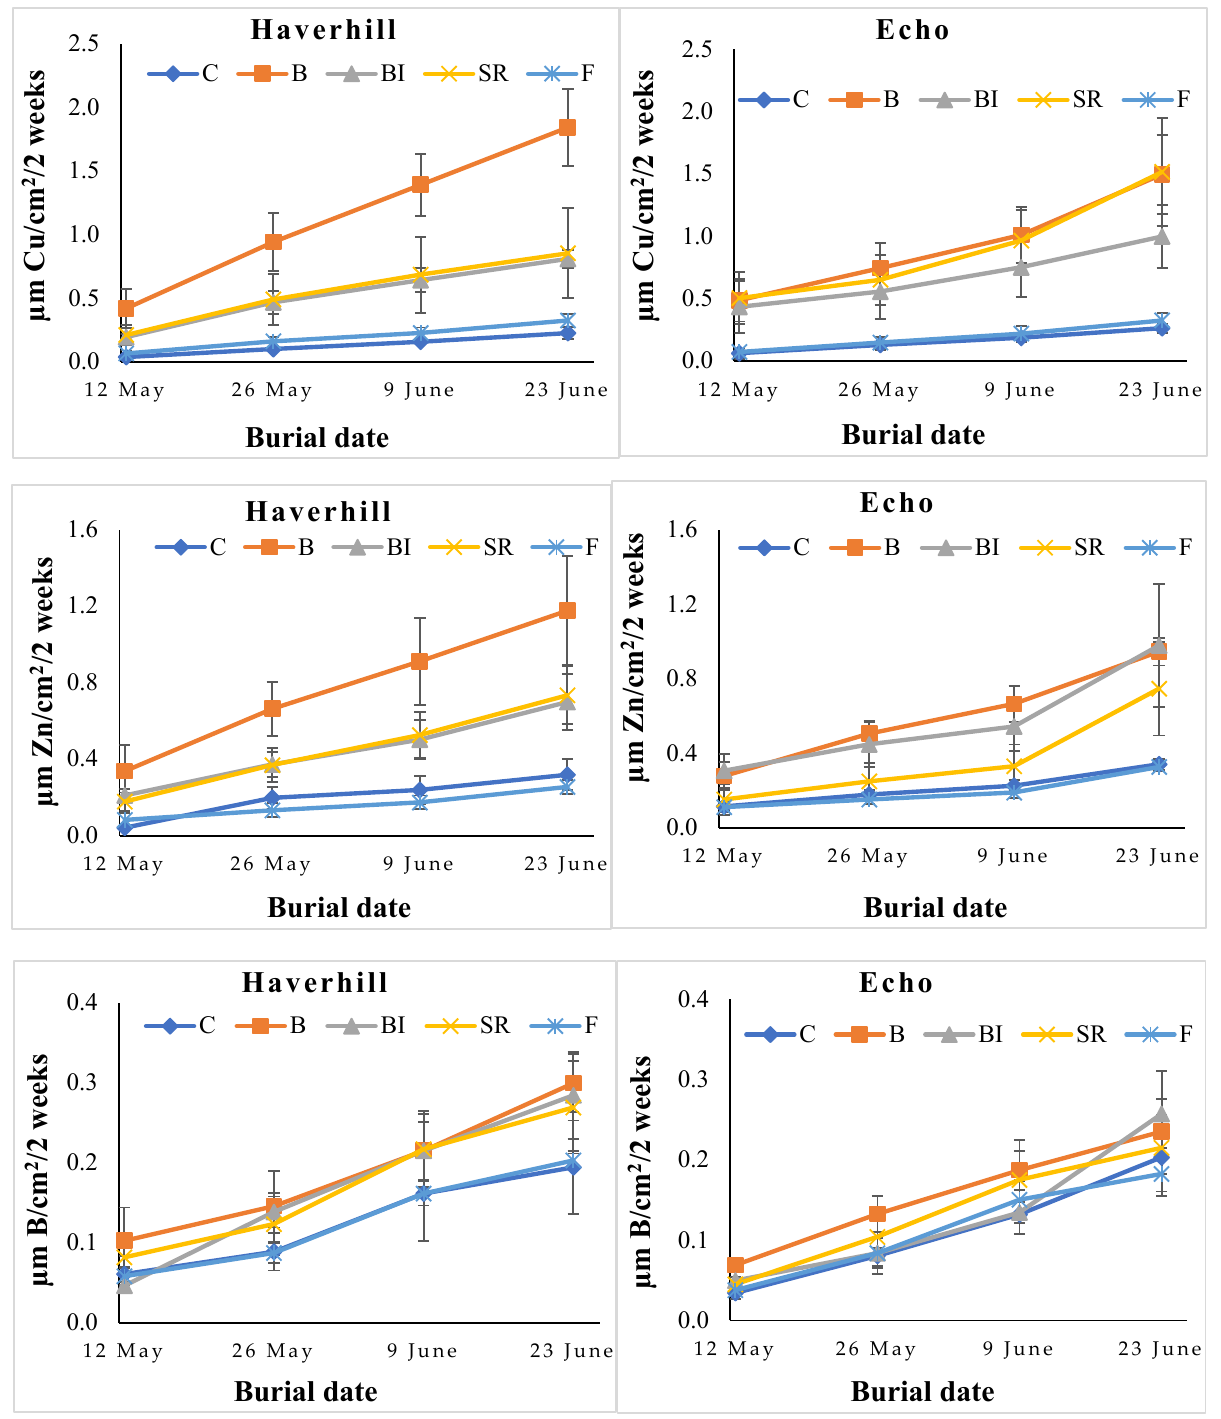
Figure 2. Mean cumulative nutrient supply rates of Cu, Zn, and B, measured by in situ burials of Plant Root Simulator (PRS)-probes at two weeks intervals during seeding to maximum vegetative growth stages. The Cu, Zn, and B fertilizer were applied for growing wheat, pea, and canola, respectively. Crops were grown at two sites in the field representing two different landscape elevation positions classified as Haverhill (upslope) and Echo (downslope) soil associations, respectively. Treatment evaluation includes C: control; B: broadcast; BI: broadcast and incorporation; SR: seed row banding; and F: foliar methods of fertilizer application. Error bar represents standard error of mean.